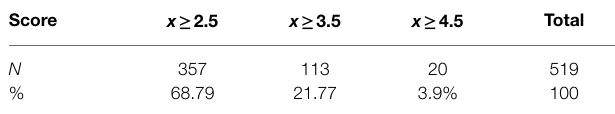
TABLE 4 | Distribution of SNSAS scores ( n = 519).